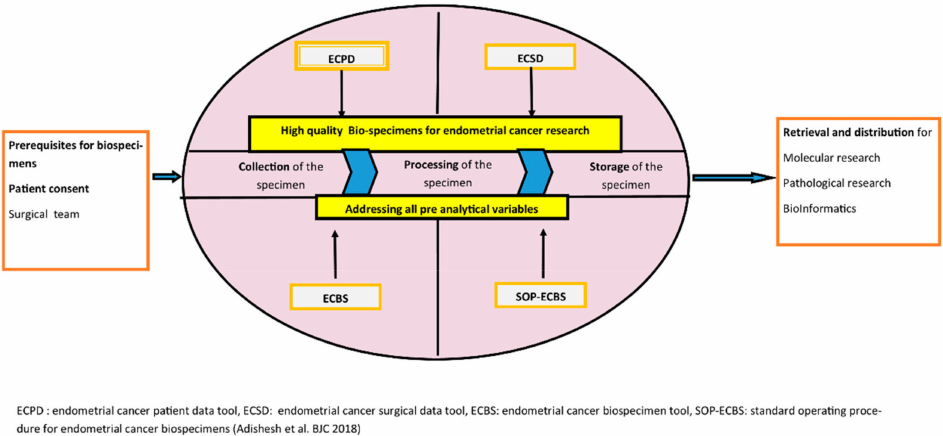
Figure 3. Journey of a biospecimen. Schematic representation of the utility of the tools developed with the HASTEN study (Harmonization of biobAnking STandards in Endometrial caNcer research). ECPD: Endometrial cancer patient data tool, ECSD: Endometrial cancer surgical data tool, ECBS: Endometrial cancer biospecimen tool, SOP-ECBS: Standard operating procedure for endometrial